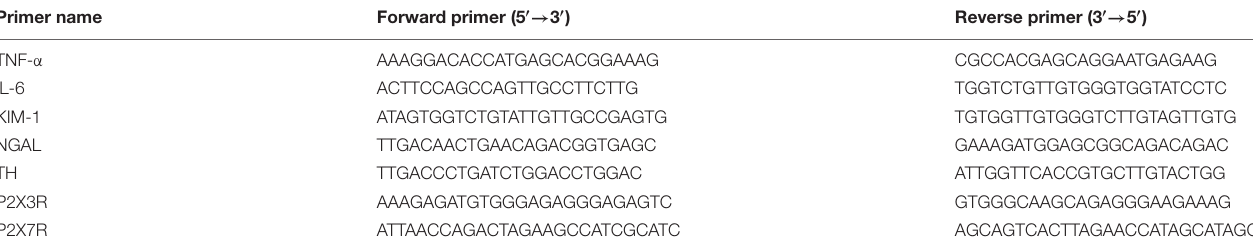
TABLE 1 | Primers used for real-time